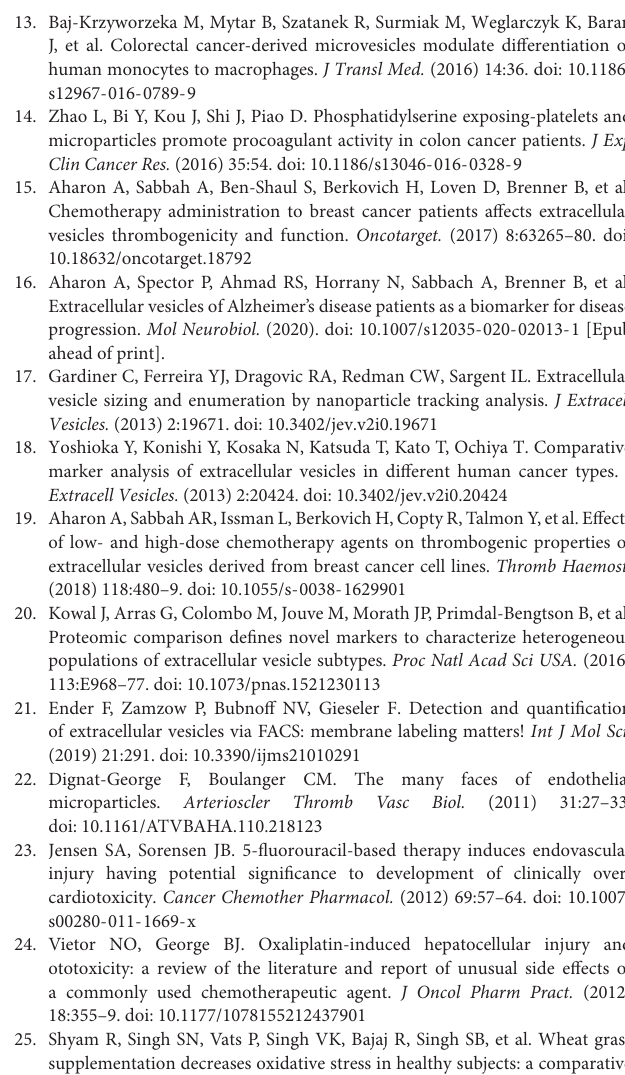
FIGURE S1 | Ratios of protein content free in plasma or packed in EVs in the study cohort. EV proteins extract was obtained from a pool of five specimens within each patient subgroup were validated by Human Angiogenesis Protein Antibody Array. Ratio of protein content as free in plasma (FP) or packed on EVs in the study cohort. (a) FP-HC/EVs-HC; (b) FP-CC-C BT/EVs-CC BT; (c) FP-CC-C3/EVs-CC3; (d) FP-CC-W BT/EVs-CC-W BT; (e)